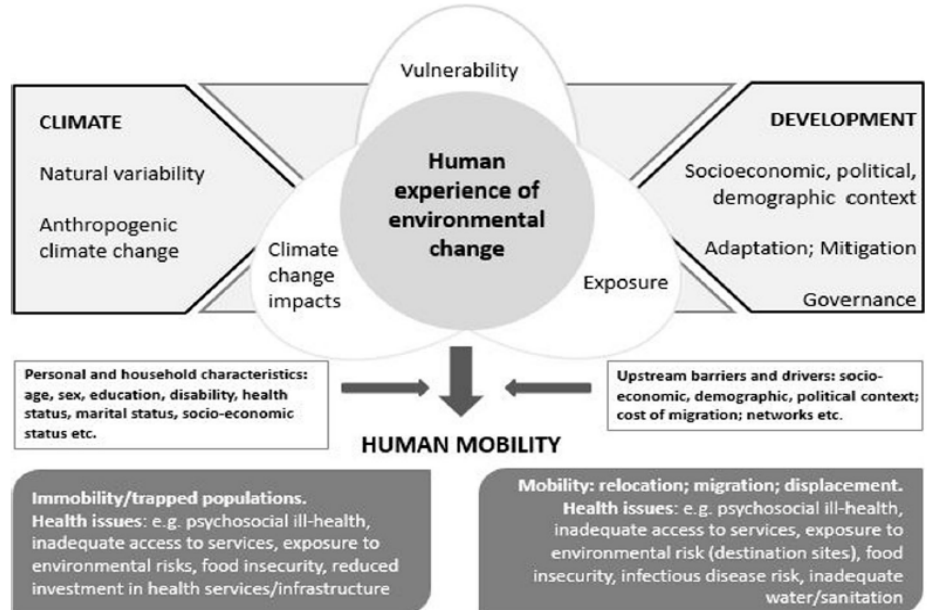
Figure 1. Conceptual framework of climate change and health risk. The relationship between climate change impacts, vulnerability, and exposure, and the links with human mobility and health outcomes [13,14]. Climate change impacts/Climate hazards: The potential occurrence of a natural or human-induced physical event or trend that may cause loss of life, injury, or other health impacts, as well as damage and loss to property, infrastructure, livelihoods, service provision, ecosystems, and environmental resources (Intergovernmental Panel on Climate Change (IPCC) Glossary). Exposure: The presence of people, livelihoods, species or ecosystems, environmental functions, services, and resources, infrastructure, or economic, social, or cultural assets in places and settings that could be adversely affected (IPCC Glossary). Vulnerability: The propensity or predisposition to be adversely affected. Vulnerability encompasses a variety of concepts and elements including sensitivity or susceptibility to harm and lack of capacity to cope and adapt (IPCC Glossary).